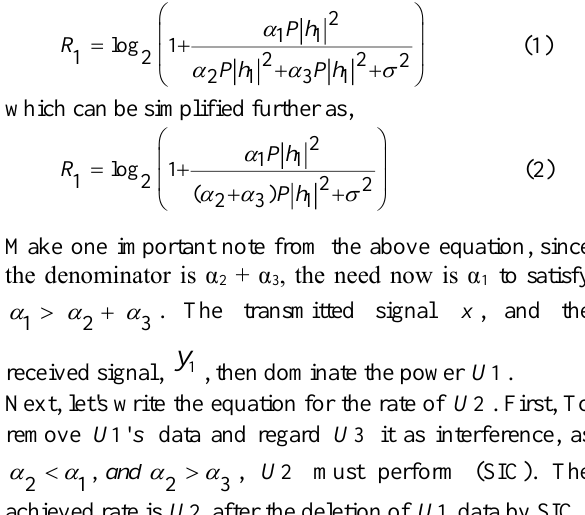
Figure 2. Wireless network NOMA PD with 3 users